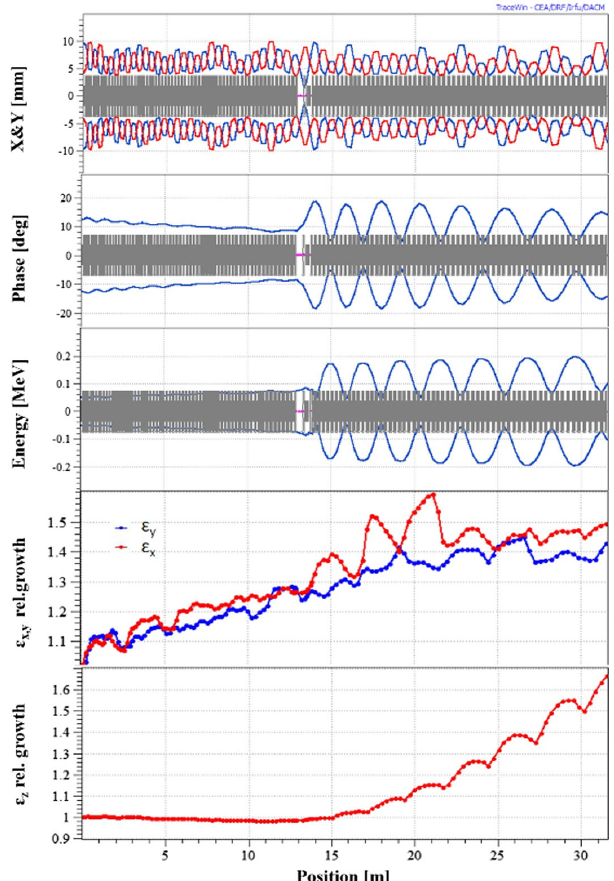
FIG. 9. Beam envelopes, transverse, and longitudinal rms- emittance growth for the prolonged cavity with one intercavity section, k 0 ;t ¼ 65 °, k 0 ;z ¼ 120